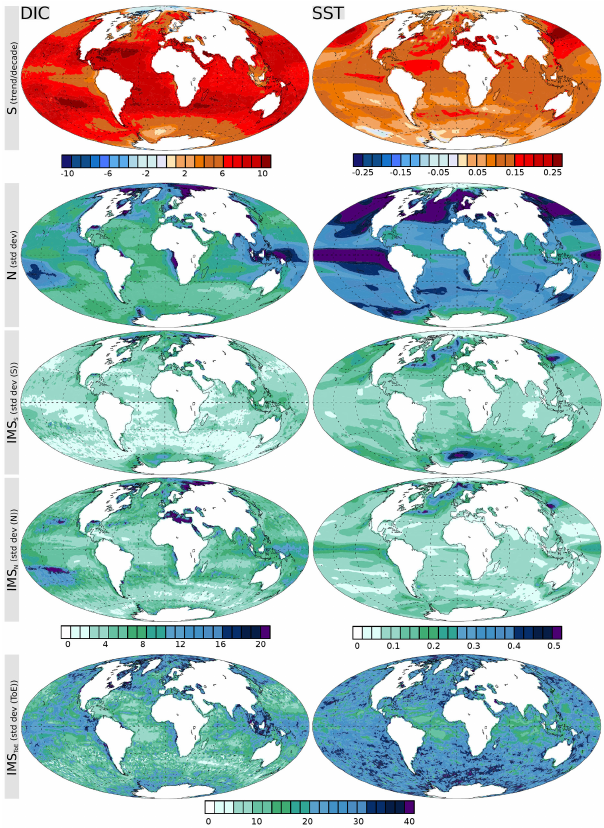
Figure 3b. Trend per decade ( S ), standard deviation ( N ) and, as measures for the inter-model spread (IMS), standard deviations of S (IMS S ), N (IMS N ), and ToE (IMS ToE ; years) of p CO 2 (ppmv) and total